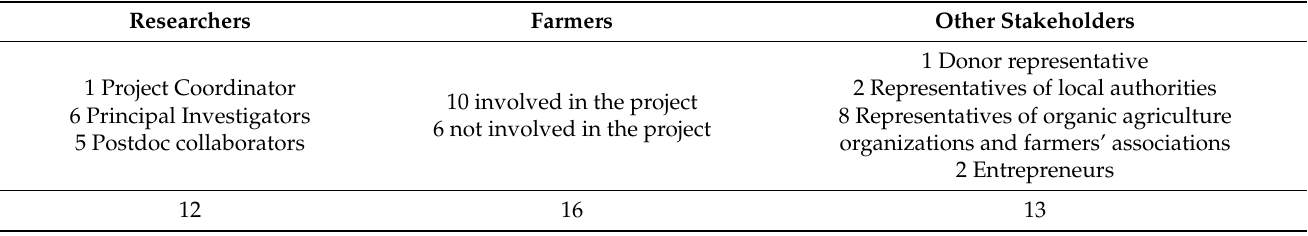
Table 2. Overview of interviews